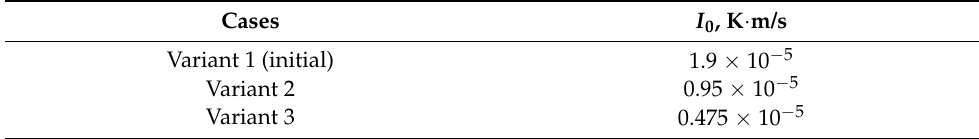
Table 1. Considered variants of radiative intensity.